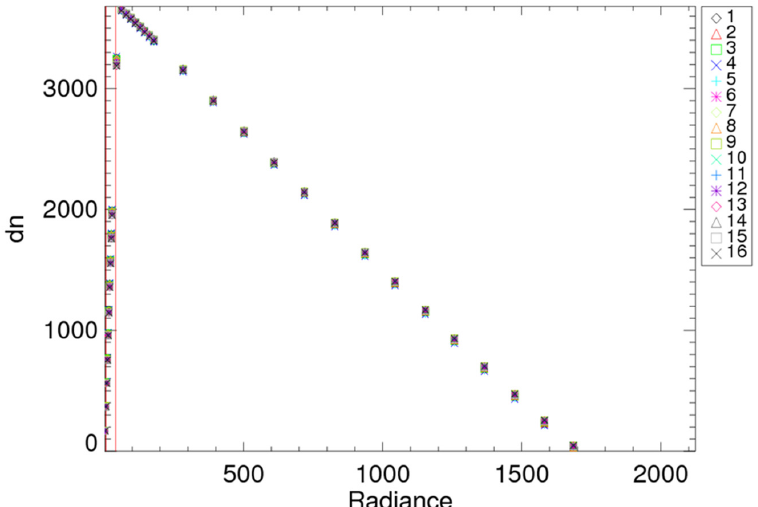
Figure 9. Band M6 dynamic range measurements for all detectors, legend in the upper right, for HAM side B. The y -axis is offset subtracted VIIRS response, and the x -axis is the SIS100 radiance during the measurement. The vertical red line corresponds to Lmax, and the saturation occurs before the line. The rollover in the response is due to saturation of the focal plane electronics. This causes two unique radiance levels to produce the same VIIRS digital number.